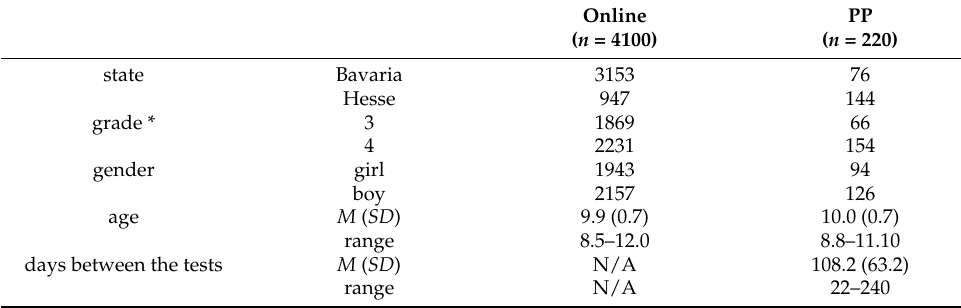
Table 1. Descriptive statistics for the samples of the online and PP